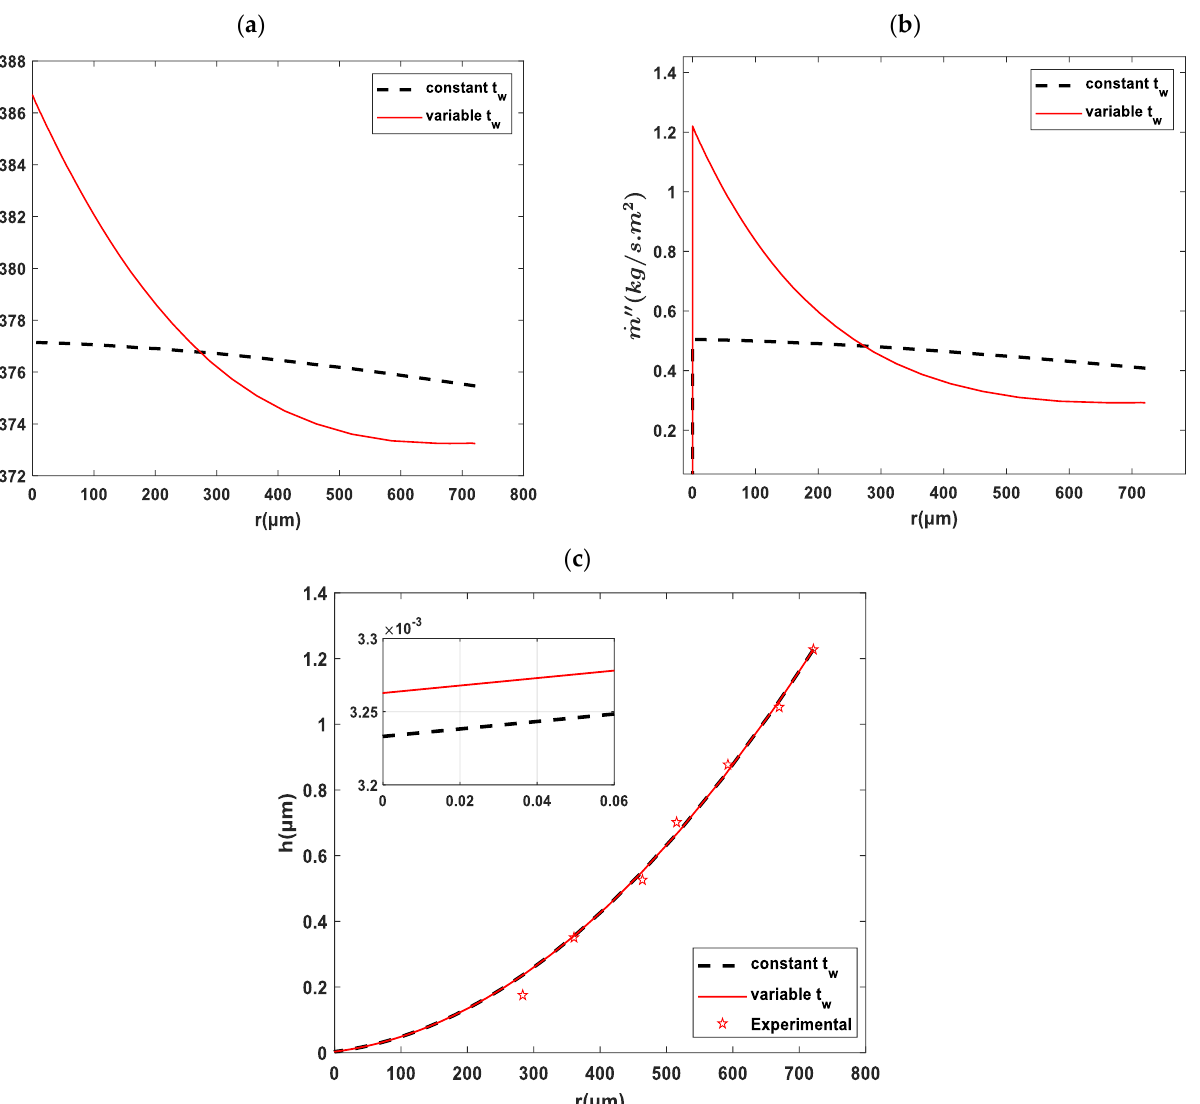
Figure 7. Radius evolutions of ( a ) interfacial temperature; ( b ) evaporative mass flux; and ( c ) film thickness for different conditions at a time step of 3.9 ms.